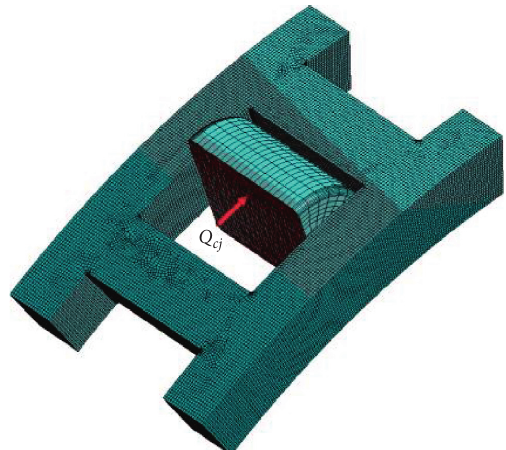
Figure 8: Finite element model of roller to cage contact.